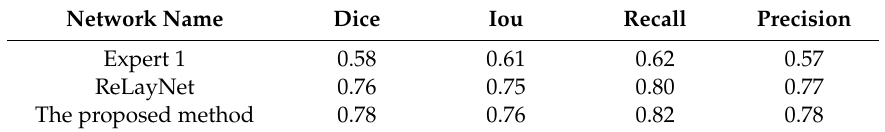
Table 6. Quantitative comparison of segmentation results with expert 2 annotations as the ground truth.